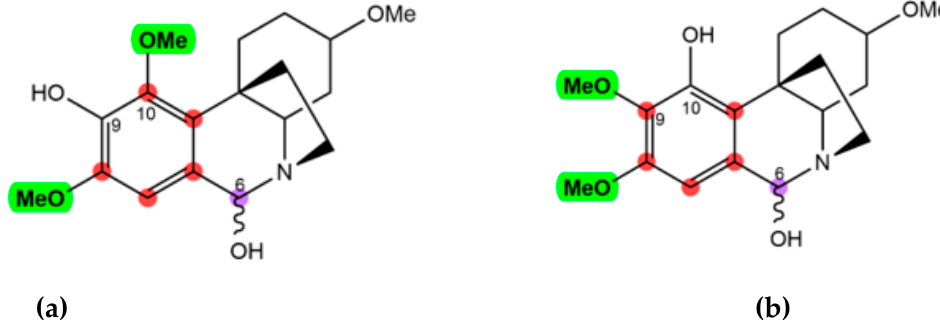
the plane ( α -orientation). Figure 6. Observed HMBC correlations between H-6 (in purple) and carbons of the aromatic ring (in